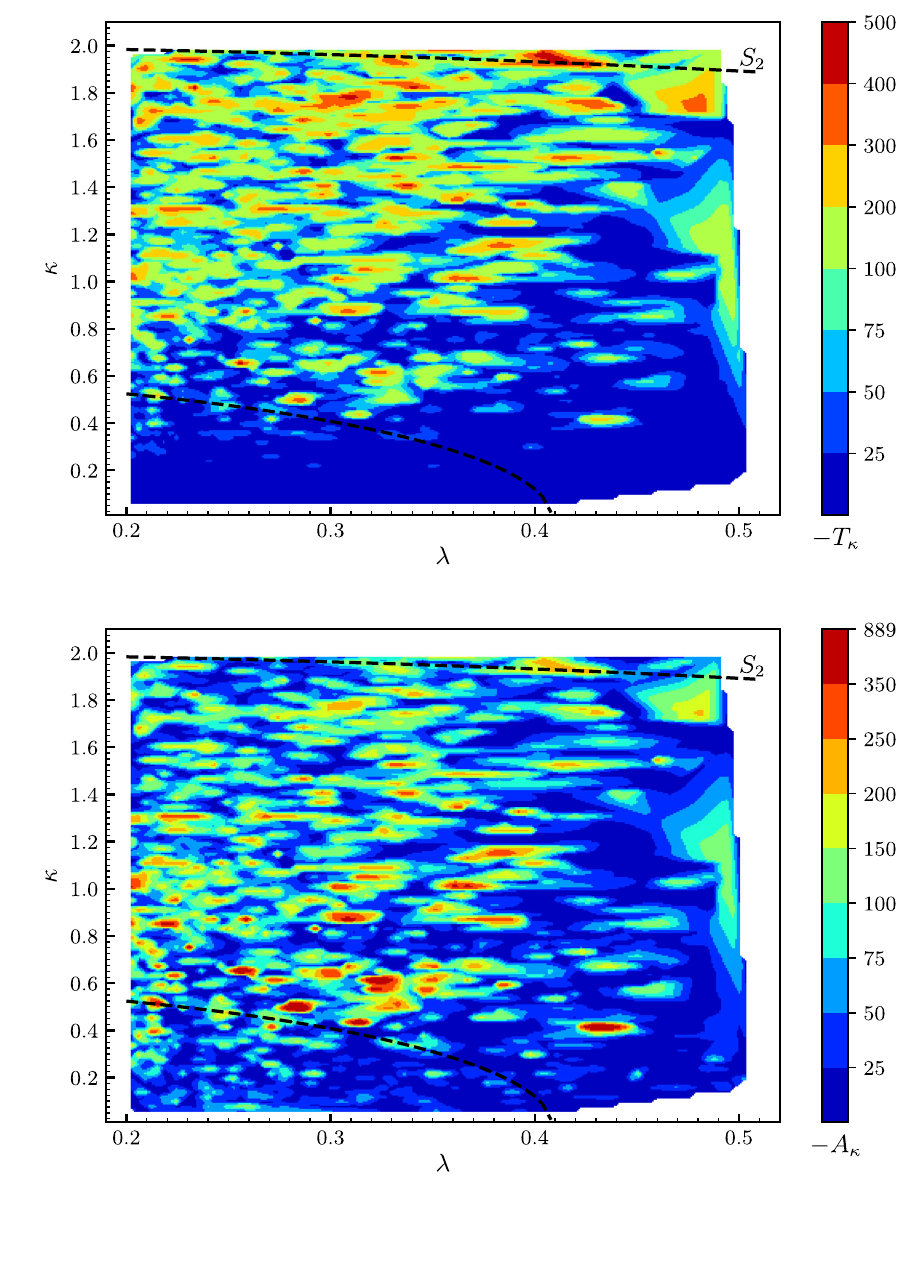
Fig. 30 The same as in Fig. 24, but the colours indicate different low-energy values of the trilinear soft terms T κ